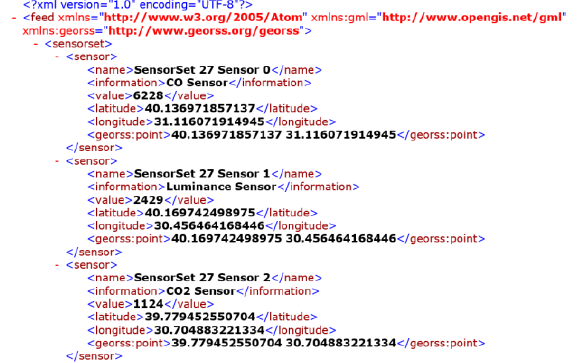
Figure 6. XML Representation of Sensors in Virtual